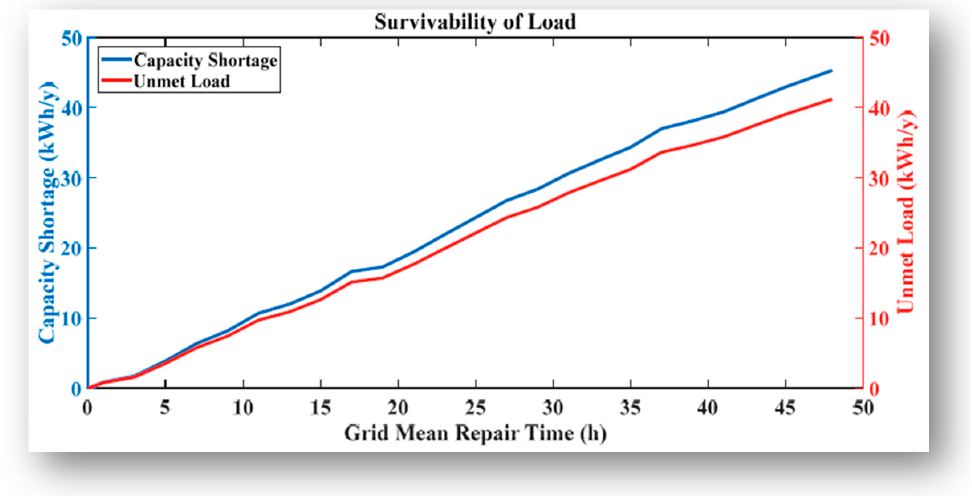
Figure 8. Grid Figure 8. Grid Outage. Figure 8. Grid Outage.